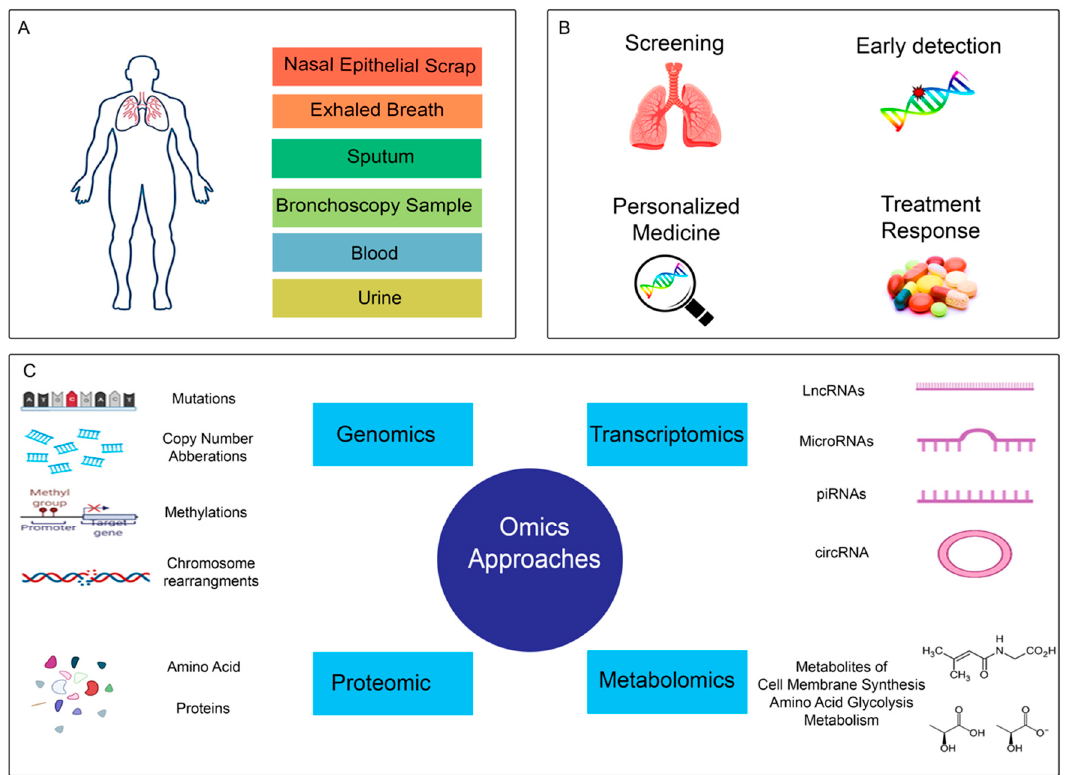
Figure 1. Schematic overview of the NSCLC biomarker discovery. ( A ) Different samples. Nasal epithelial scraping, exhaled breath, sputum, bronchoscopy, blood, and urine are used for NSCLC bi-